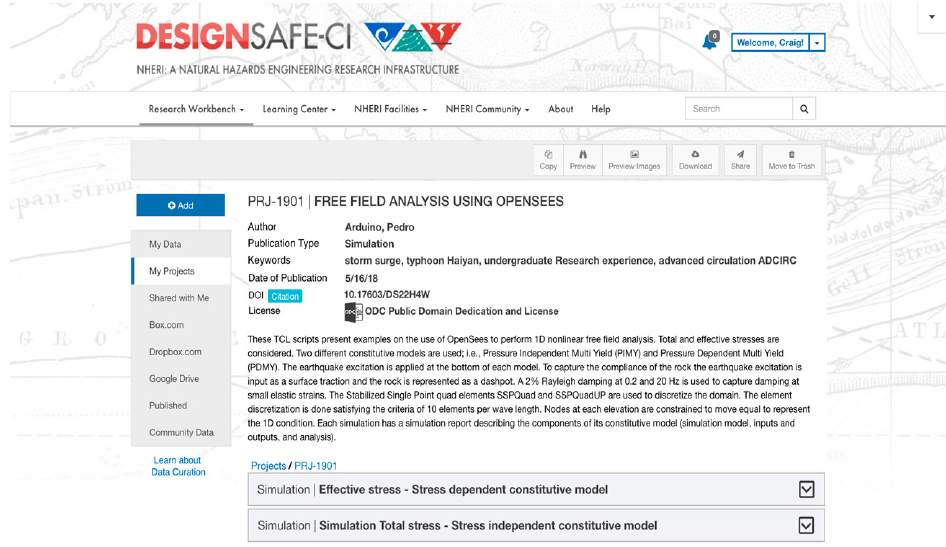
Figure 7. Browsing view with accordion of a dataset with two simulations.